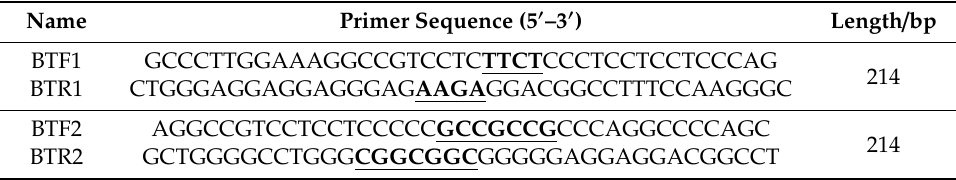
Table 2. Site-directed mutation primers of the Hu sheep BMP7